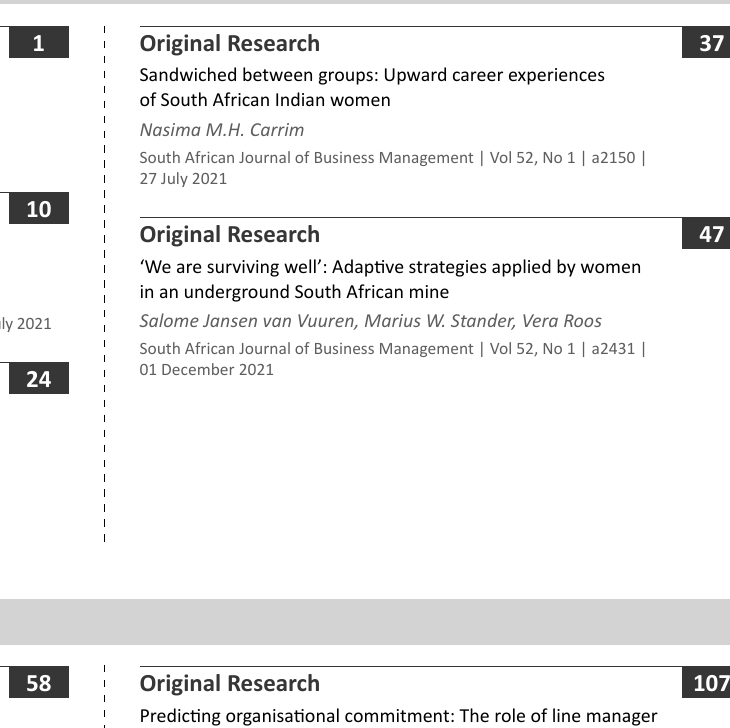
Vol 52, No 1 (2021) Special Collection: Women in Business in Africa, sub-edited by Anita Bosch (University of Stellenbosch Business School, South Africa) and Lize Booysen (Antioch University,